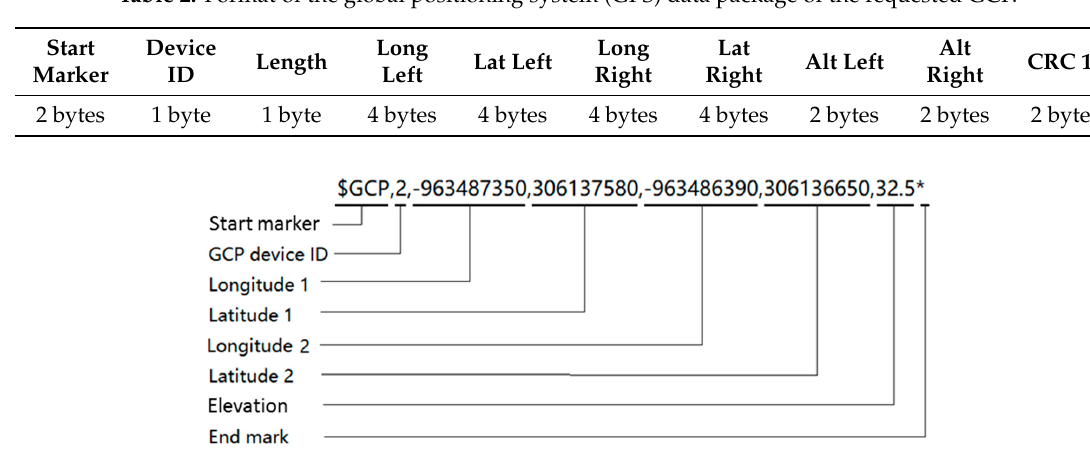
Figure 4. Structure of the GCP data transferred from the main controller to the UAV.